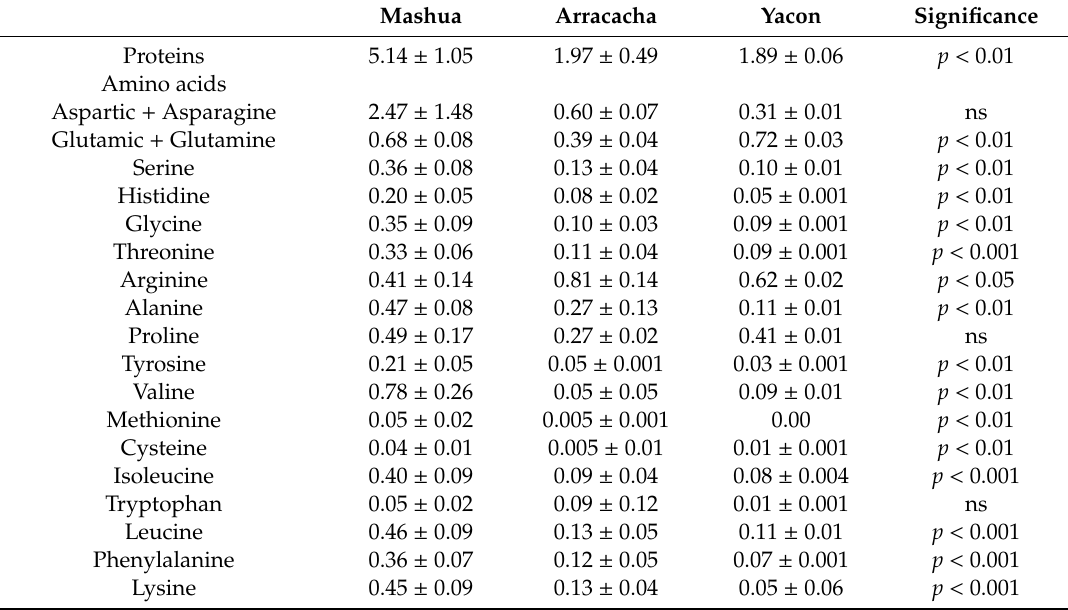
Table 7. Protein and protein amino acid concentration in mashua, arracacha, and yacon from Bolivia and Peru (in g 100 g sample − 1 ). Means of di ff erent cultivars (mashua, 7; arracacha, 2; yacon, 2) ± standard